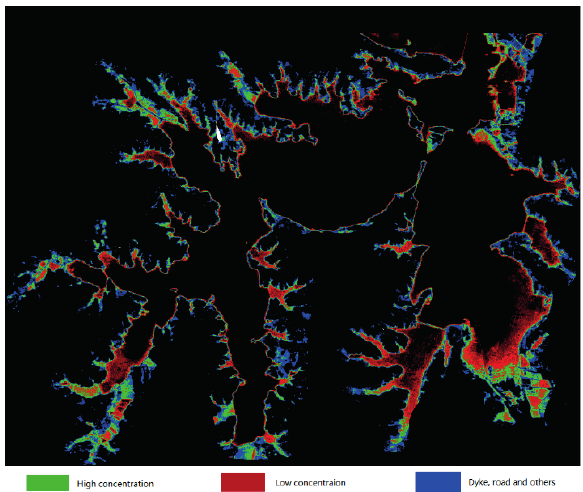
Fig. 5 Cyanobacteria bloom NDVI after FLAASH atmospheric